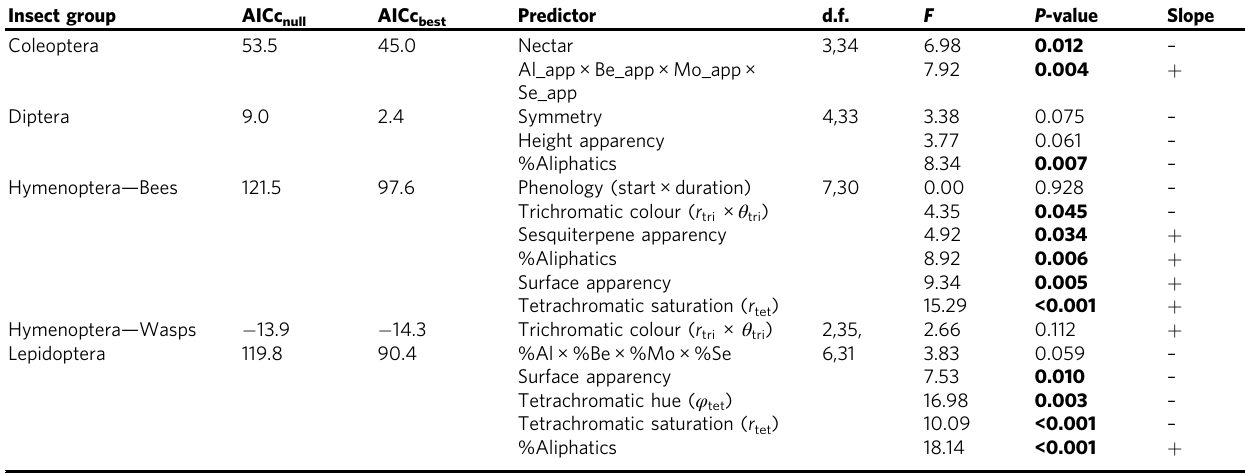
Table 3 Floral traits associated with visitation rates by the major pollinator groups in the